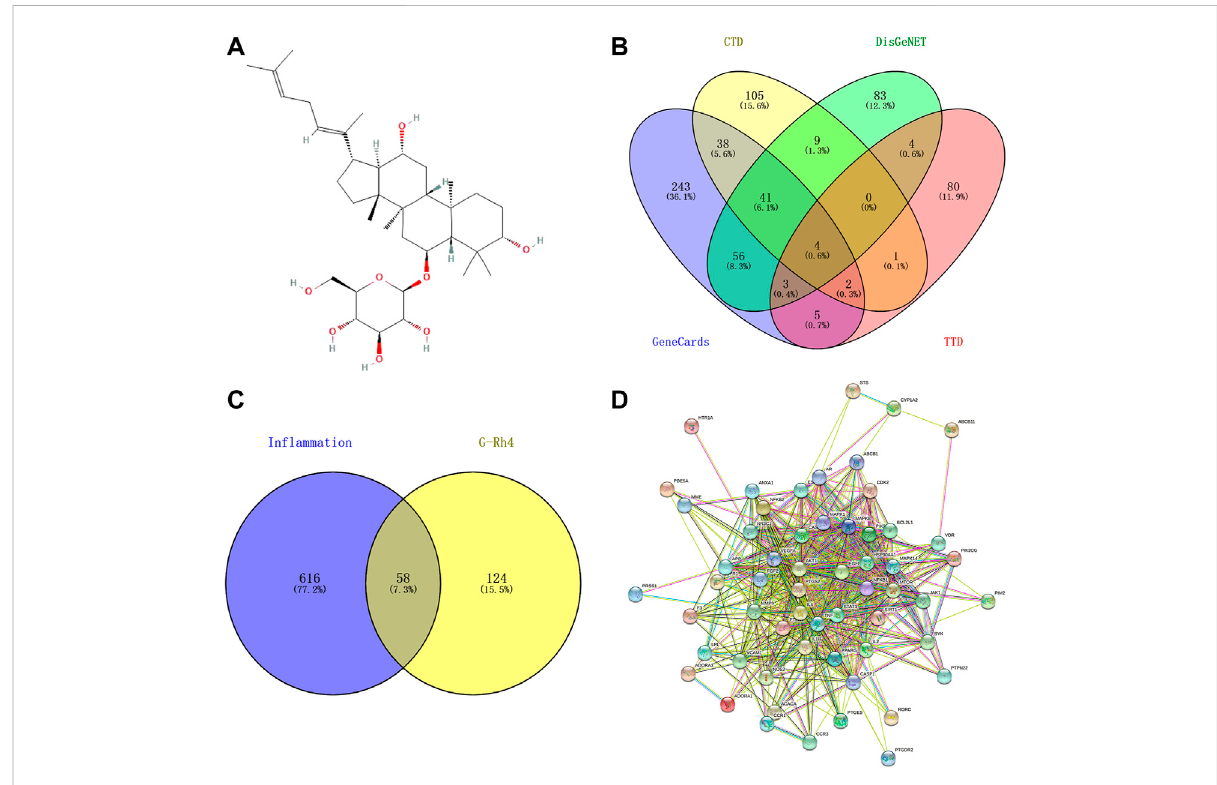
FIGURE 1 Targets screening involved in G-Rh4 for treating in fl ammation. (A) Molecule structure of G-Rh4. (B) Venn diagram of the potential in fl ammation-speci fi c targets. (C) Fifty-eight overlapping target proteins between in fl ammation-related proteins and targets of G-Rh4. (D) Protein – protein networks of overlapping 58 target proteins. Edges: Interactions between protein(s) and